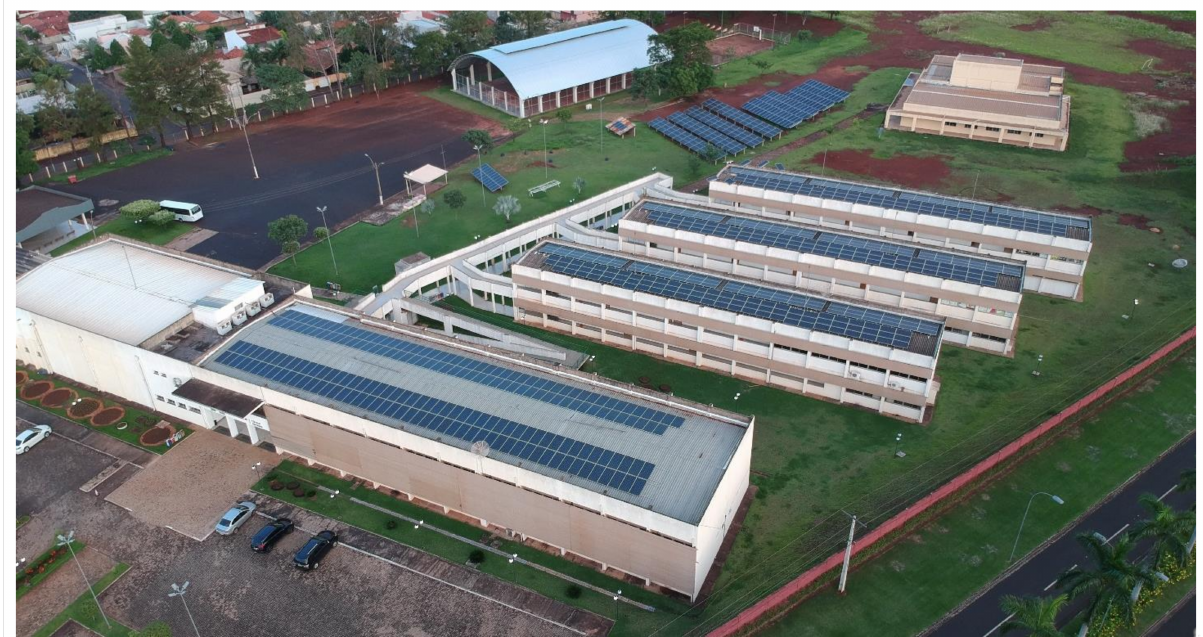
Figure 7. PV System—Itumbiara